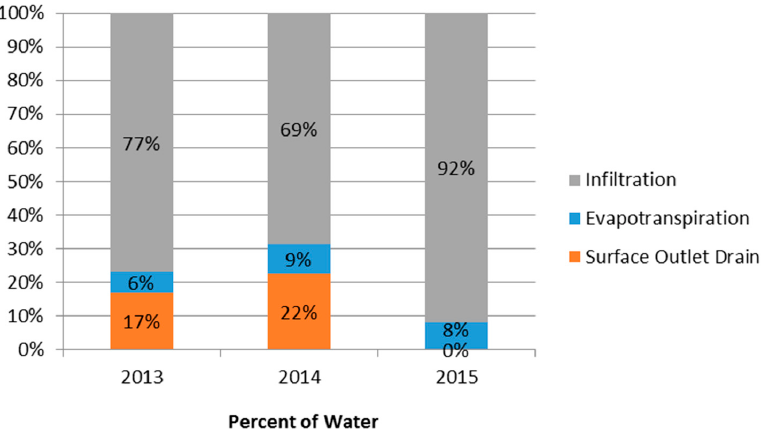
Figure 8. Outflow distribution of all water that entered the wetland each year. The total water volume includes direct precipitation over the wetland.